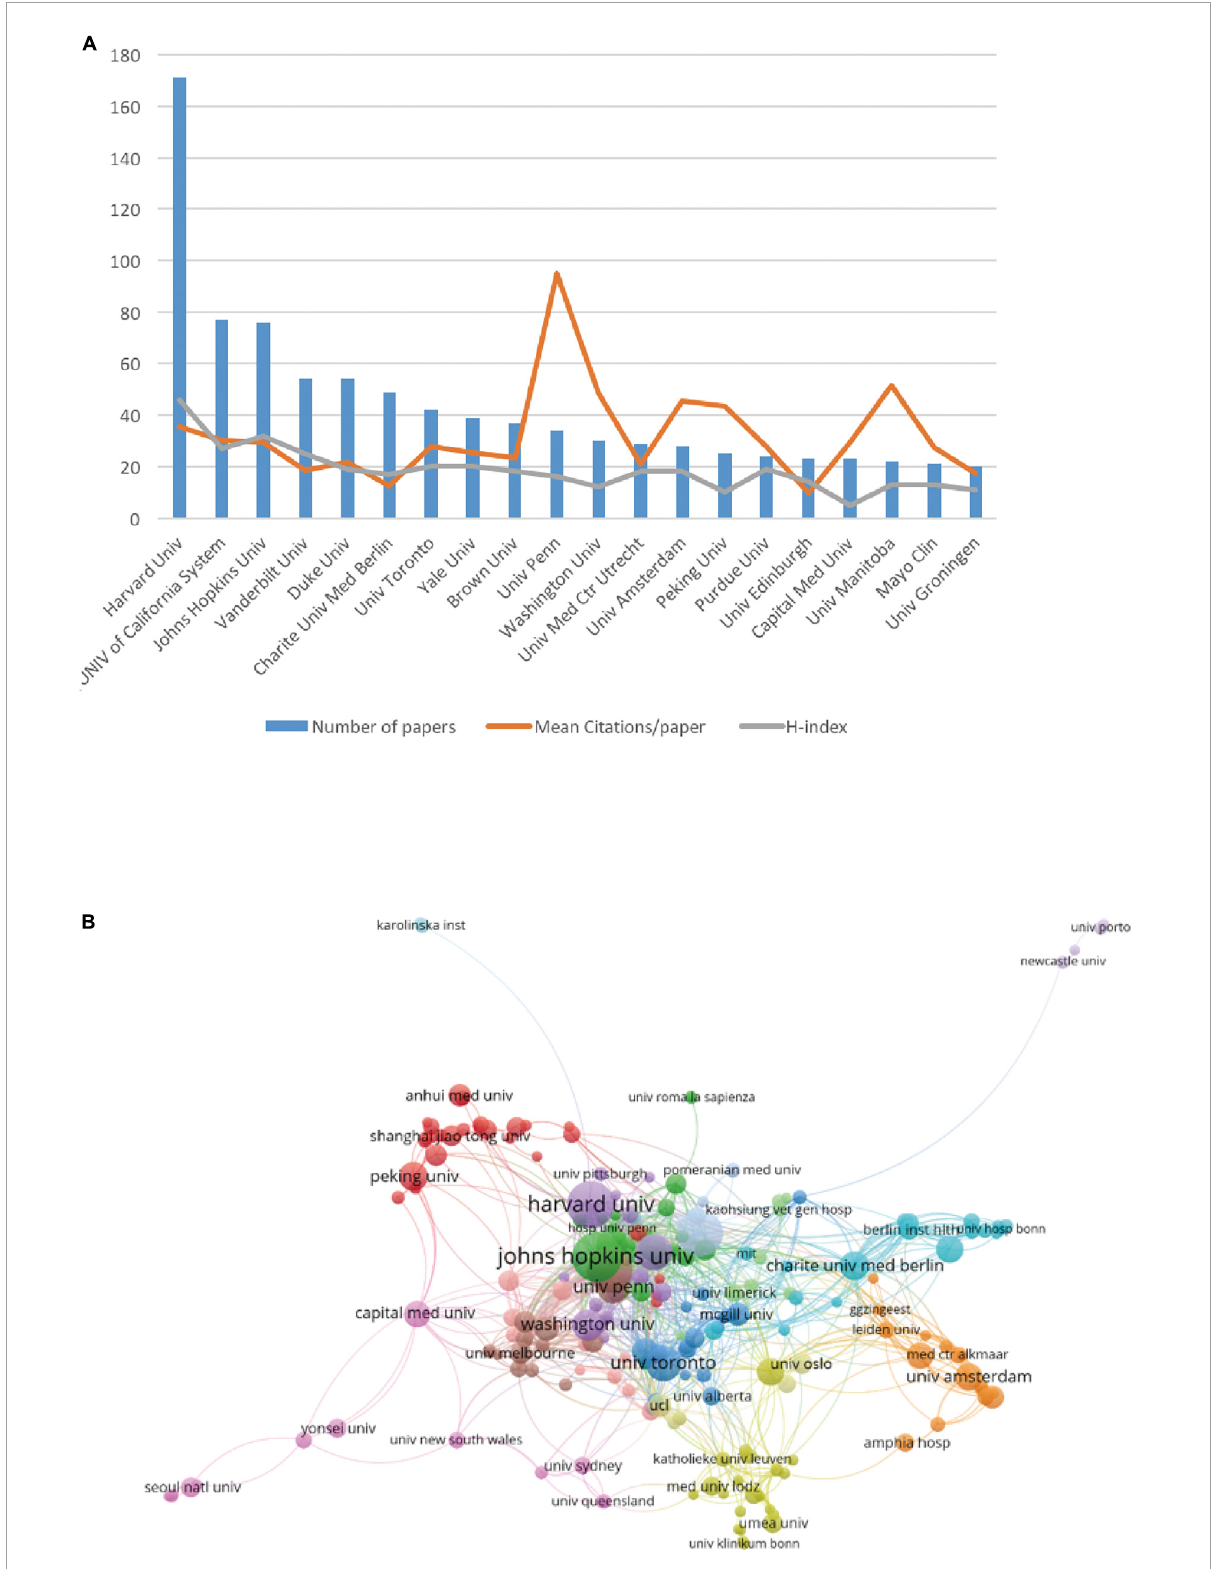
FIGURE3 The articles on postoperative delirium (POD) published by different research institutions. (A) The top 20 most productive institutes. The blue bar graph represents the number of articles published by each institution, the red line represents the average number of citations per article, and the green line represents the H-index of each institution. (B) The network visualization map indicating collaborations between institutions.